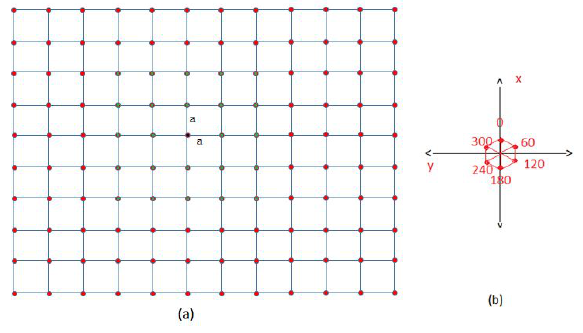
Figure 8: Grid Map. Suppose the black dot is a previously visited coordinate then its neighbors are the green dots. 1 unit in X and Y is equal to ‘a’ which is the distance between recorded images.